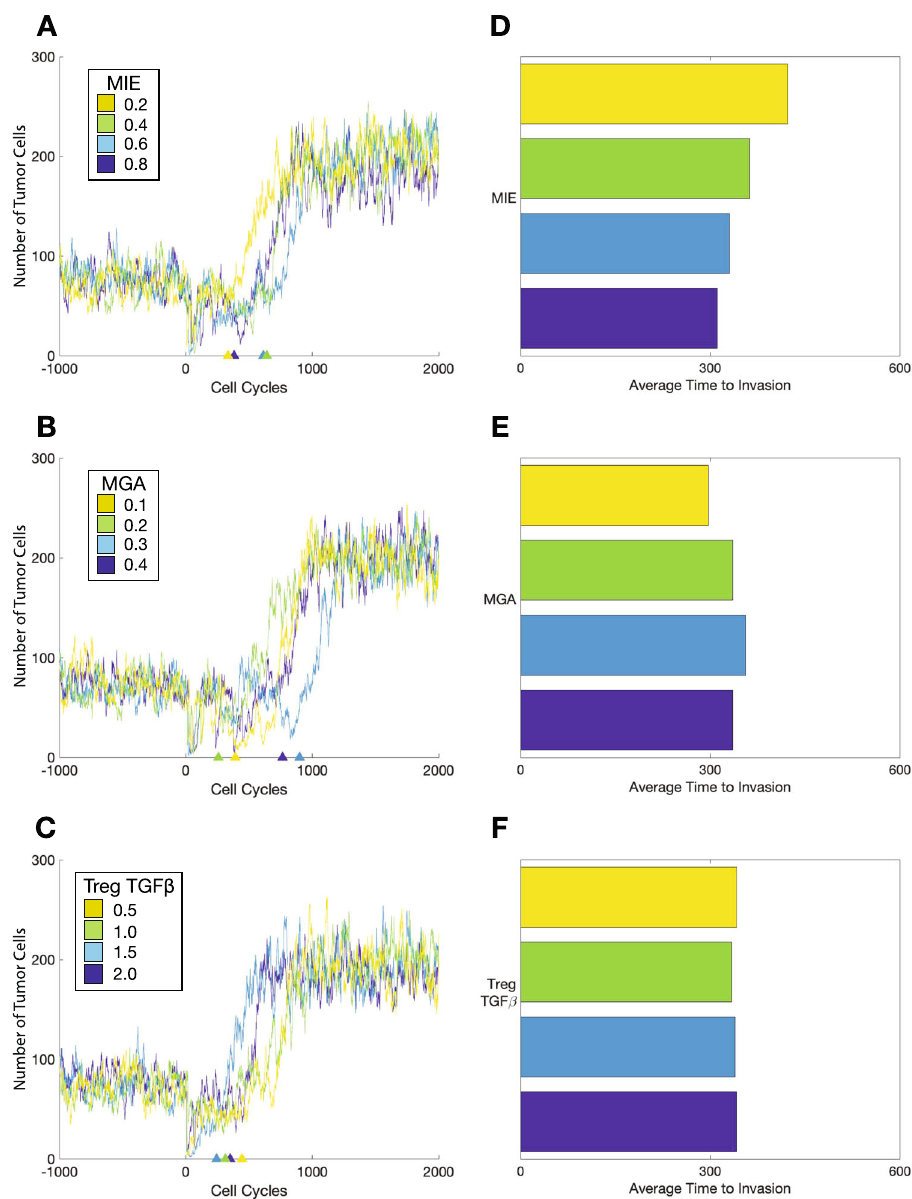
Fig. 3 Effects of mesenchymal tumor cell properties on the time to invasion. Trajectories of one patient per cohort including warmup and 2000 cell cycles for A mesenchymal immune evasion (MIE); B mesenchymal growth arrest (MGA); C production of TGF - β by Tregs. D Average times to invasion for a patient cohort of 1000 for changes in MIE. E Average times to invasion for a patient cohort of 1000 for changes in MGA. F Average times to invasion for a patient cohort of 1000 for changes in Treg production of TGF - β